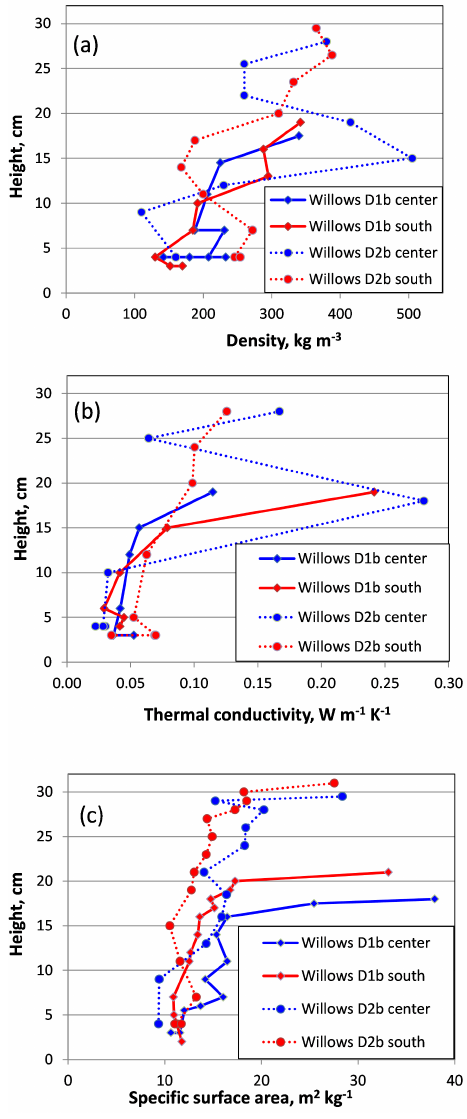
Figure 7. Physical properties of snow in isolated willow bushes (curves named “center”) and about 1m uphill (“south”) of the bush. (a) Density; (b) thermal conductivity; (c) specific surface area. In the basal depth hoar, several measurements were sometimes made at the same